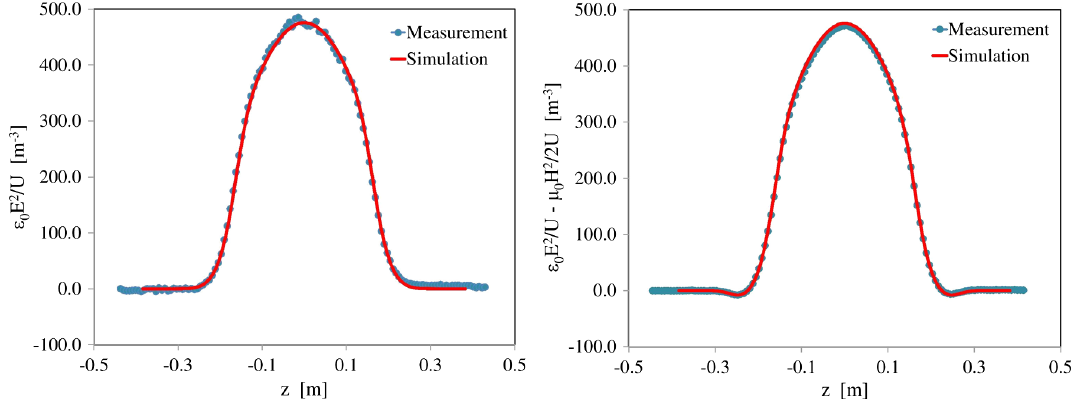
FIG. 5. Bead pull measurements from the dielectric (left) and metallic (right) spherical beads.